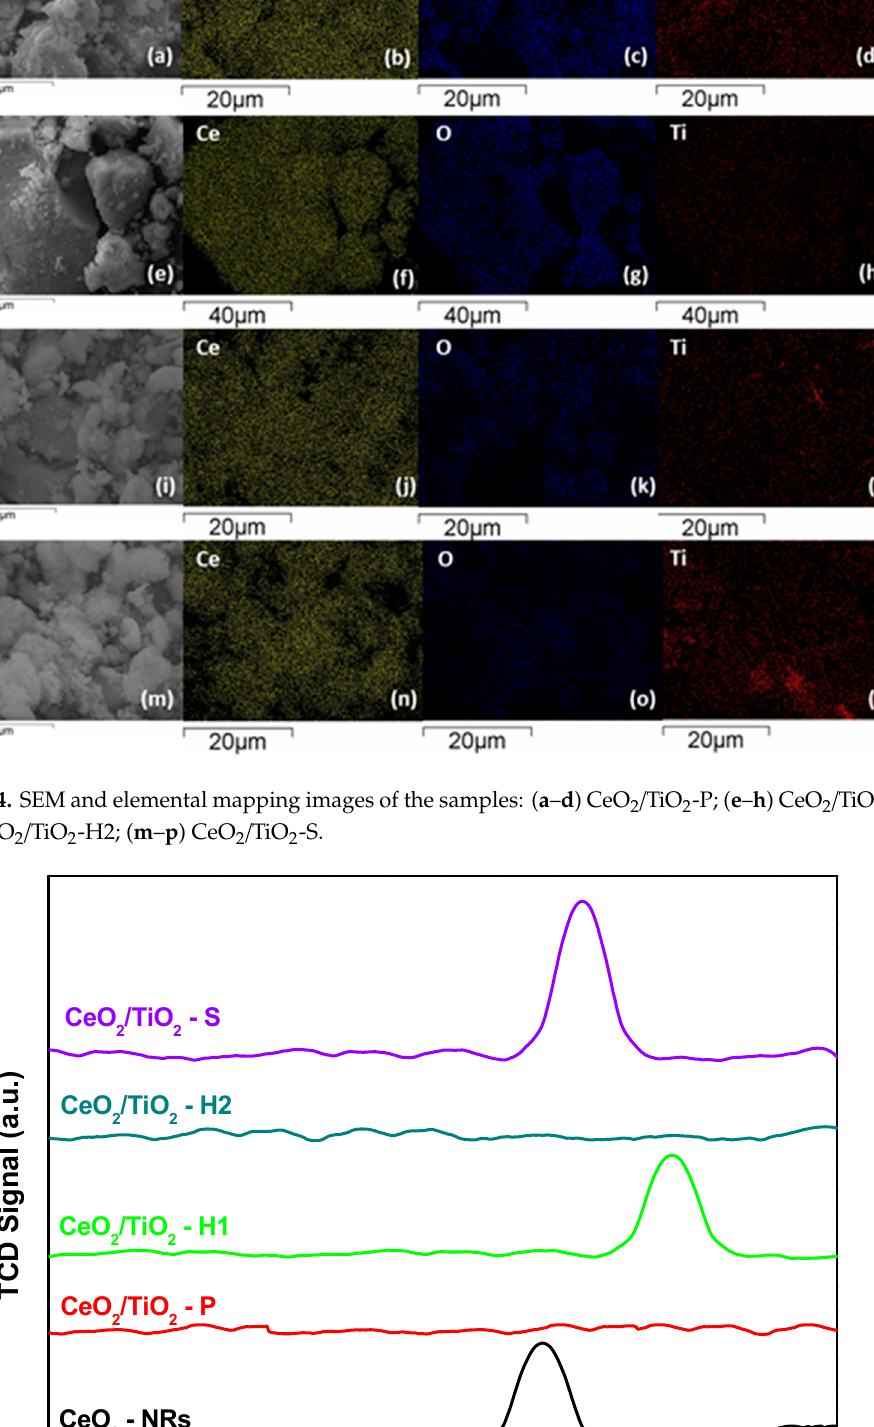
Figure 5. H 2 -TPR profiles of CeO 2 -NRs and CeO 2 /TiO 2 samples.